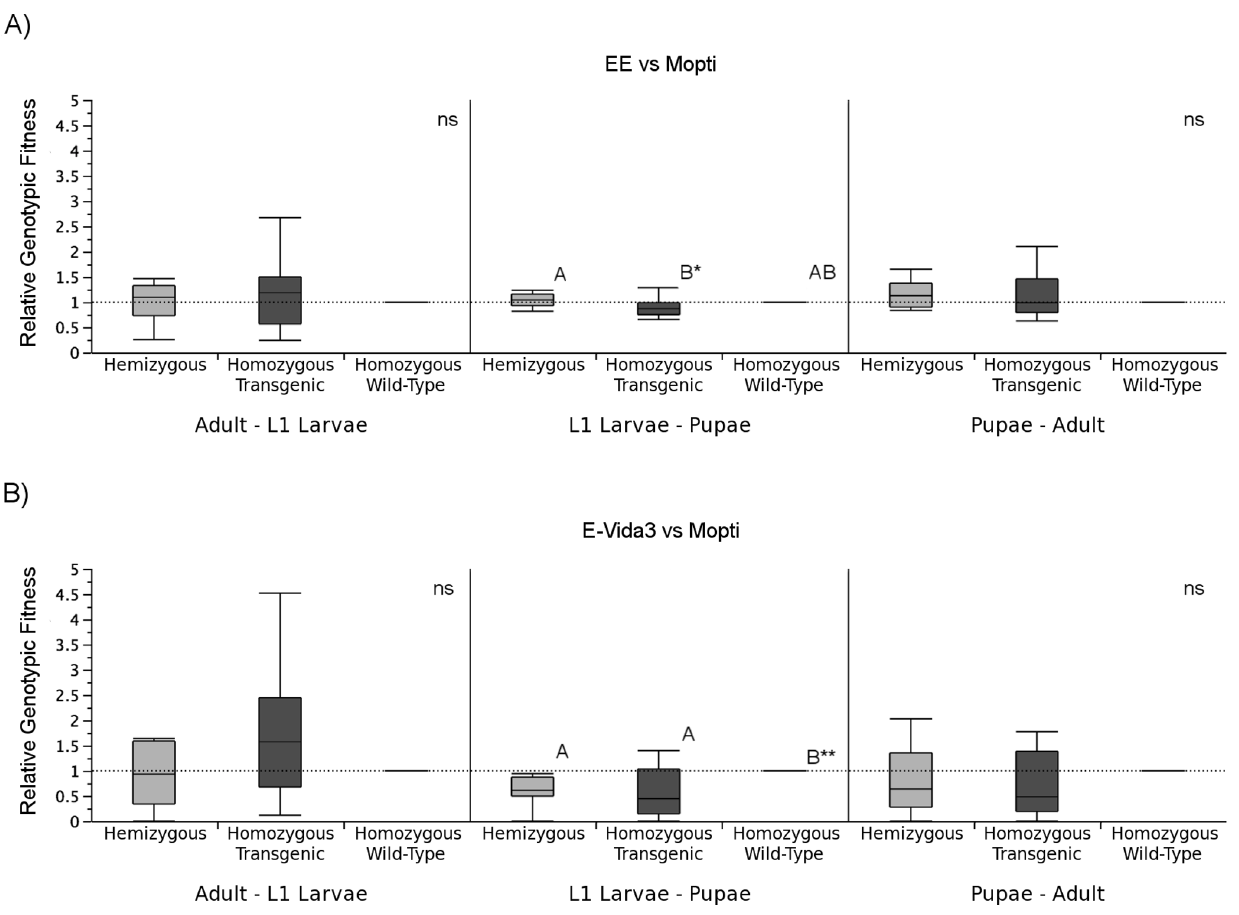
Figure 5. Genotypic fitness for hemizygotes and transgenic homozygotes relative to homozygous wild-type individuals over three developmental periods. In A) the fitness of the homozygous and hemizygous Phase-1 EE genotypes were compared to wild-type homozygotes; in B) the fitness of the homozygous and hemizygous Phase-2 EVida3 genotypes were compared to wild-type homozygotes. Boxplots were median, quartiles and min-maximum values. The significance levels of a pairwise Wilcoxon test are indicated - ns, not significant, *: P , 0.05, ** P , 0.01, *** P , 0.001.